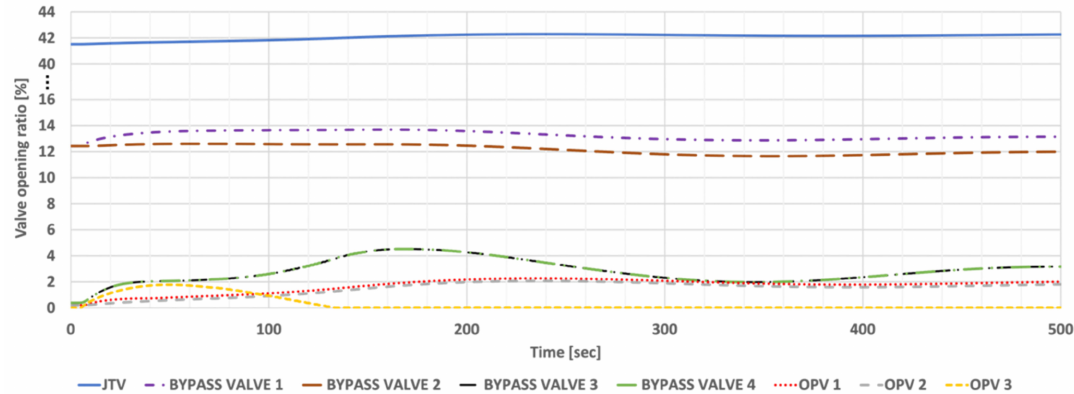
Figure 14. Valve opening ratio when one engine is tripped.